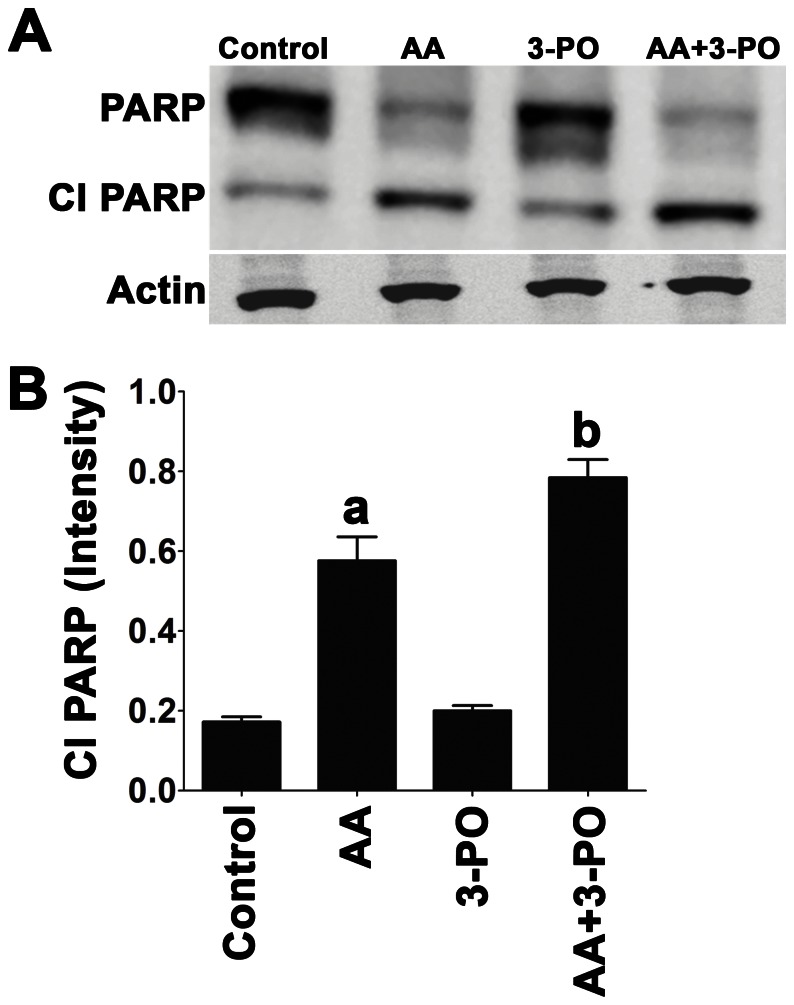
Induction of PARP cleavage in H1299 cells by combination of AA and 3-PO.(A) H1299 cells were treated with either AA (300 µM), 3-PO (10 µM), or the combination of AA and 3-PO. Cells were harvested 24 h after treatment and protein extracts subjected to immunoblot analysis using a PARP-specific antibody. Duplicate immunoblots probed with an actin-specific antibody served as normalization controls. (B) Quantitation of the levels of cleaved PARP (Cl PARP) was done using image analysis of the immunoblots using Carestream Molecular Imaging Software version 5.0. The intensity measurements shown represent means ±SEM determined from three independent experiments. a; statistically significant difference (P<0.05) from vehicle treated control. b; statistically significant difference (P<0.05) from control and individual AA and 3-PO treatments.